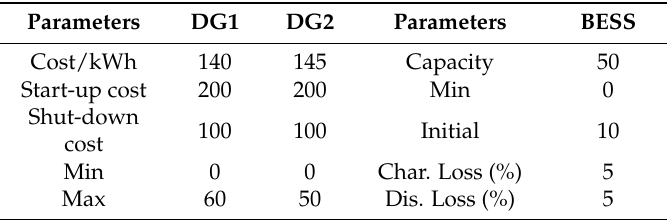
Table 1. Parameters related to DG units and BESS of the MG